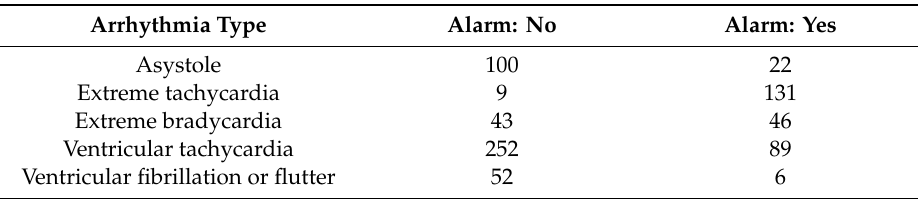
Table 2. Arrhythmia